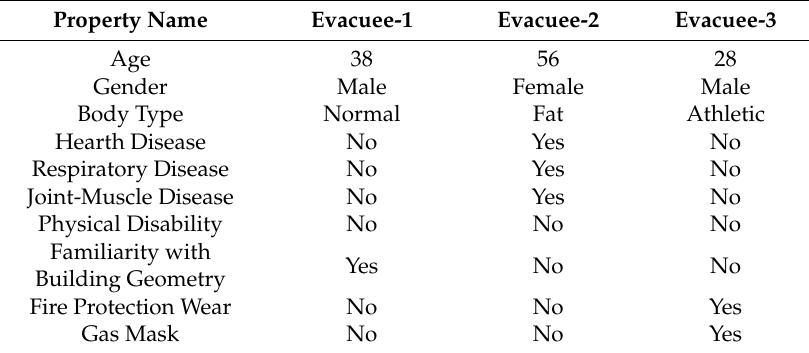
Table 6. User profiles in scenarios.